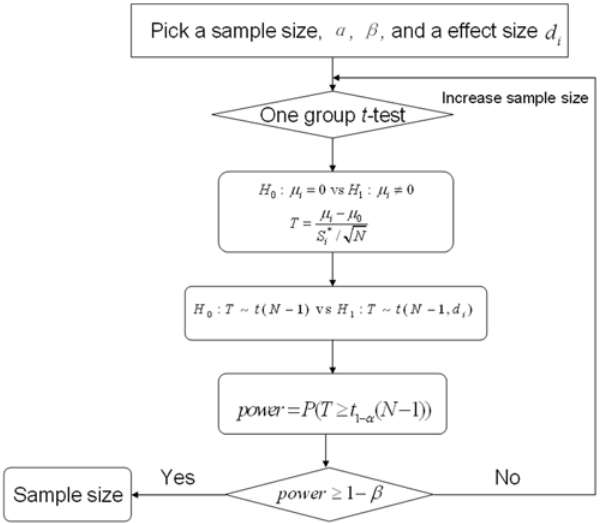
Figure 3. Power analysis algorithm for the estimation of the minimum sample size.